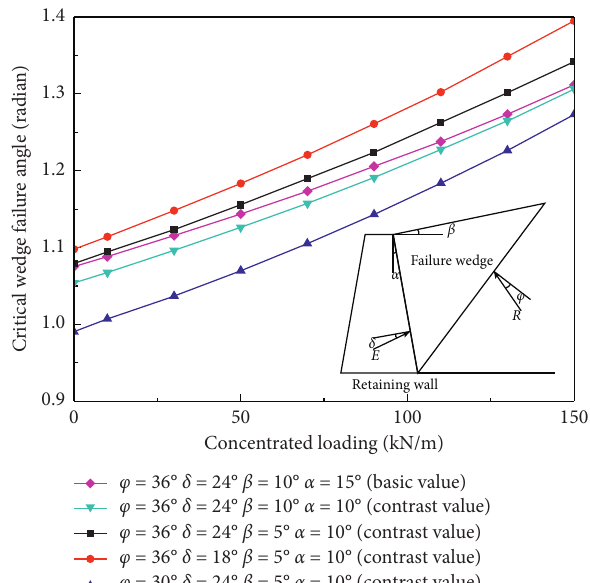
Figure 8: Variations of the critical wedge failure angle θ